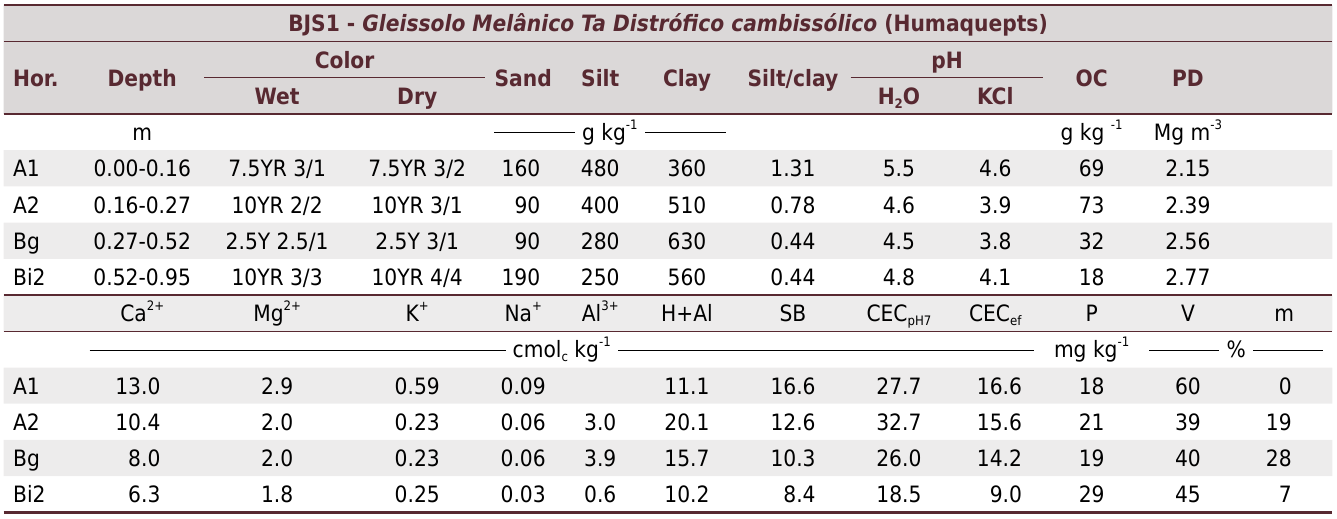
Table 2. Morphological, physical, and chemical properties of the soils collected in the wetland of Bom Jardim da Serra (BJS), SC, Brazil BJS1 - Gleissolo Melânico Ta Distrófico cambissólico (Humaquepts)